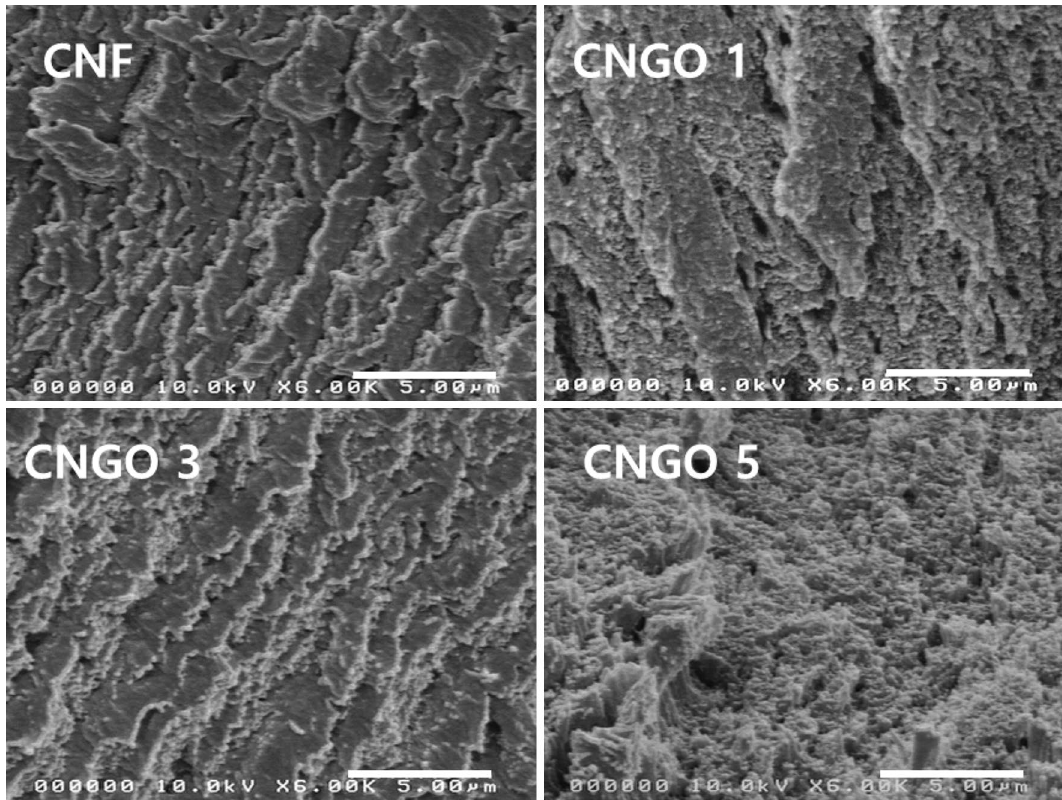
Figure 3. The fractured-surface SEM images of the pristine CNF and CNGO hybrid filament with different GO concentrations.